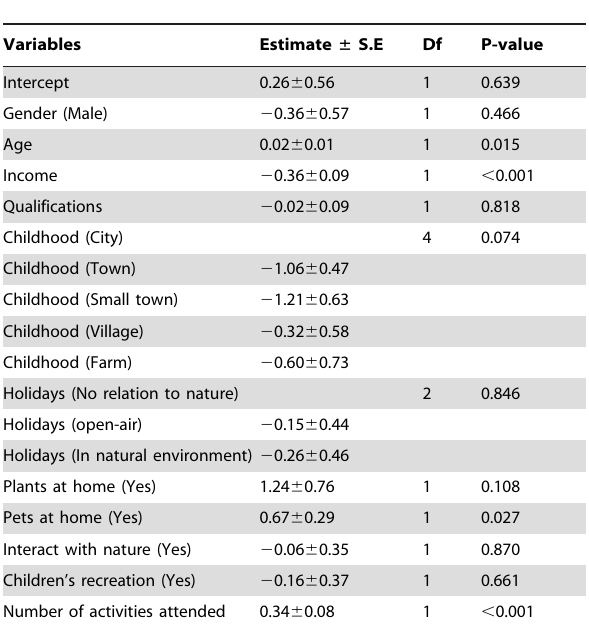
Table 4. The results of the general linear model, with quasi- Poisson distribution errors, are given to account for the variance in taking flyers, by profiles, garden variables and the number of activities in which each attendee participated